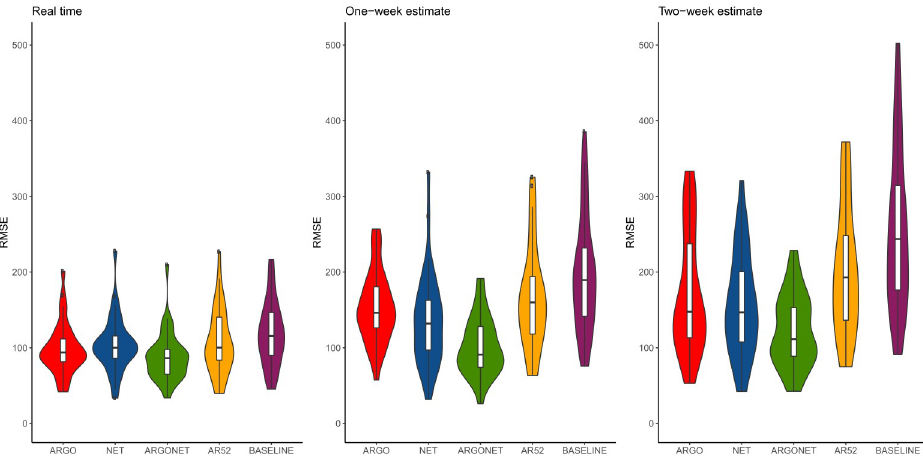
Fig 14. Nouvelle-Aquitaine two-week ahead